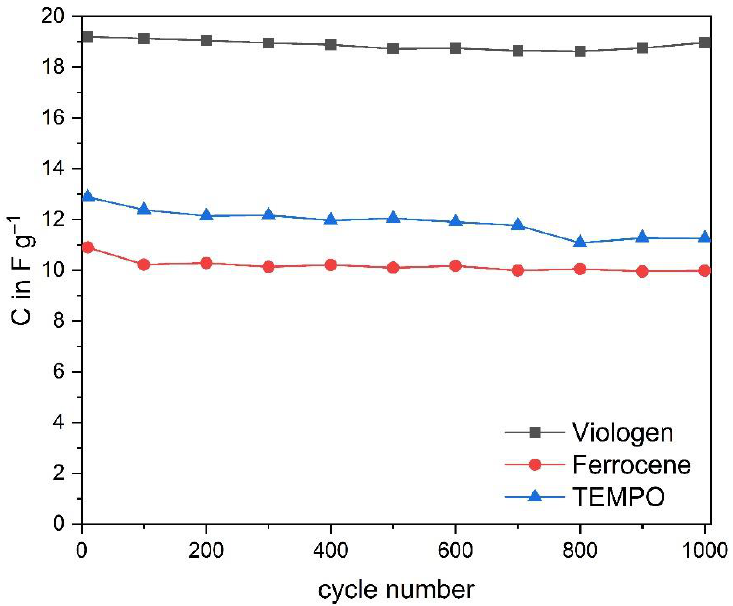
Figure 7. Cycling stability of 0.1 M RAILs in Pyr 14 TFSI at 0.1 A g − 1 in symmetrical full-cell setup with AC electrodes over 1000 cycles.